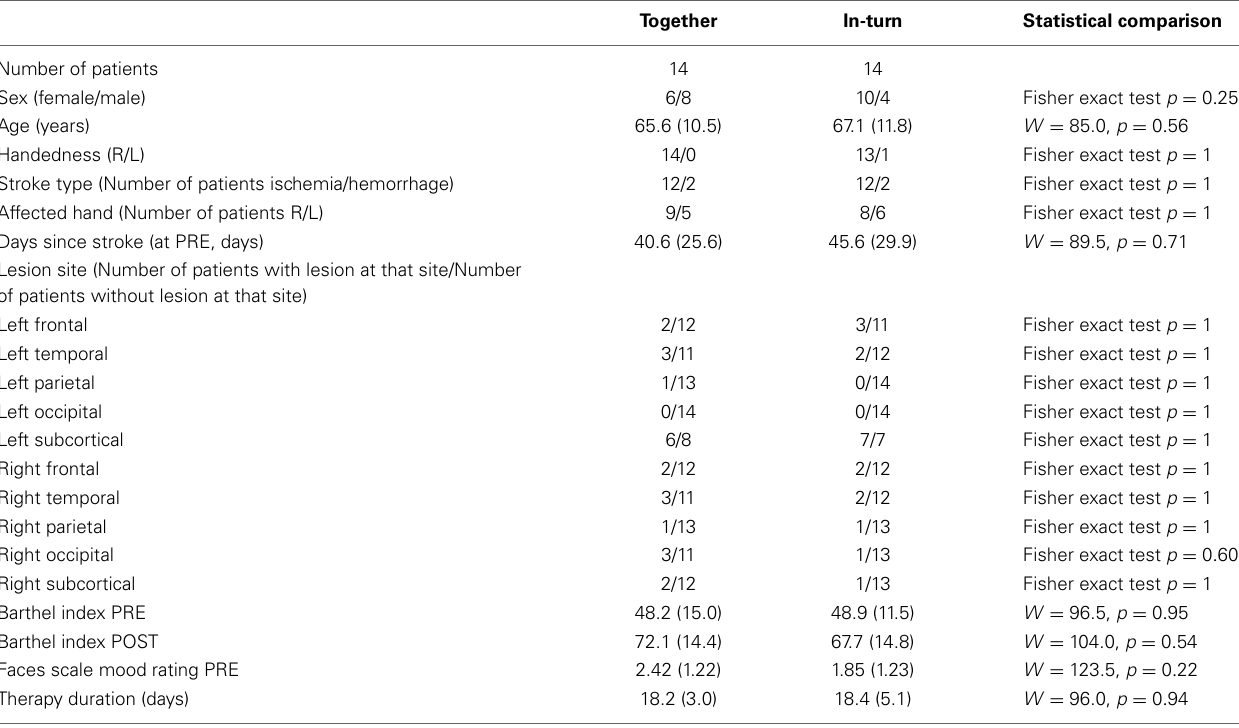
Table 1 | Clinical data of the two patient groups.